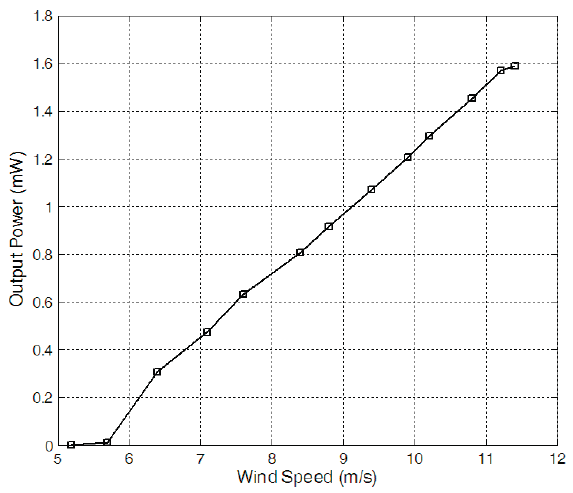
Figure 5. Output power on a 20 k Ω resistor versus wind speed.